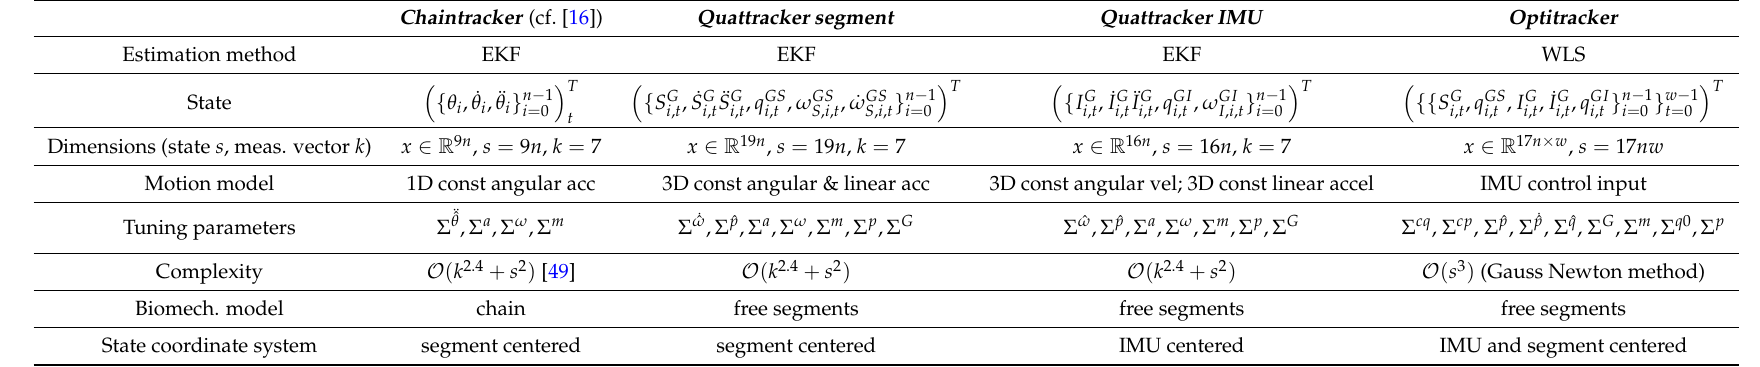
Table 1. Characteristics of the different sensor fusion methods: n denotes the number of segments and w is the window size used by the Optitracker . All tuning parameters are given in Appendix D. Note, θ i represent the joint angles estimated by the Chaintracker and Σ ¨ θ refers to the process noise covariances used in the dynamic model